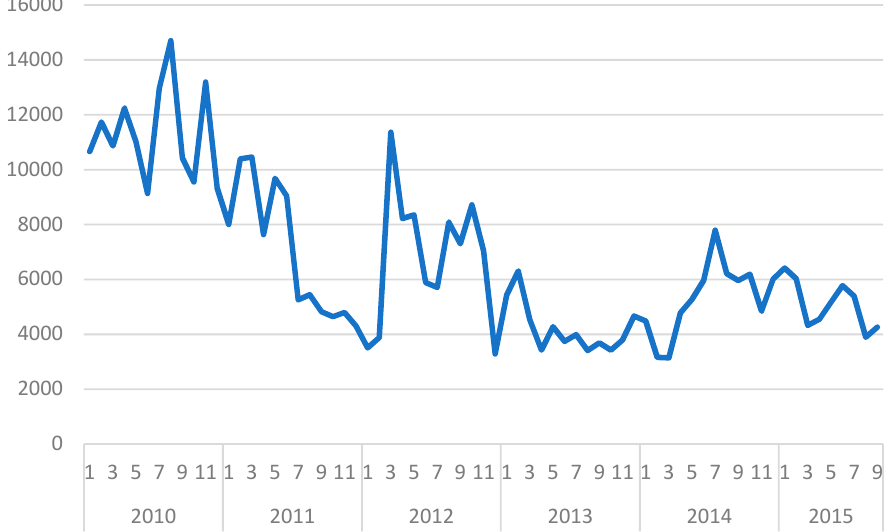
Figure 2. Transactions of Residential Properties in Hong Kong, 2010M1–2015M9. Notes: the number of transactions of residential properties in Hong Kong drops after the introduction of the Seller’s Stamp Duty (SSD) in November 2010, the Buyer’s Stamp Duty (BSD) in October 2012, and the 1st Double Stamp Duty (DSD1) in February 2013.